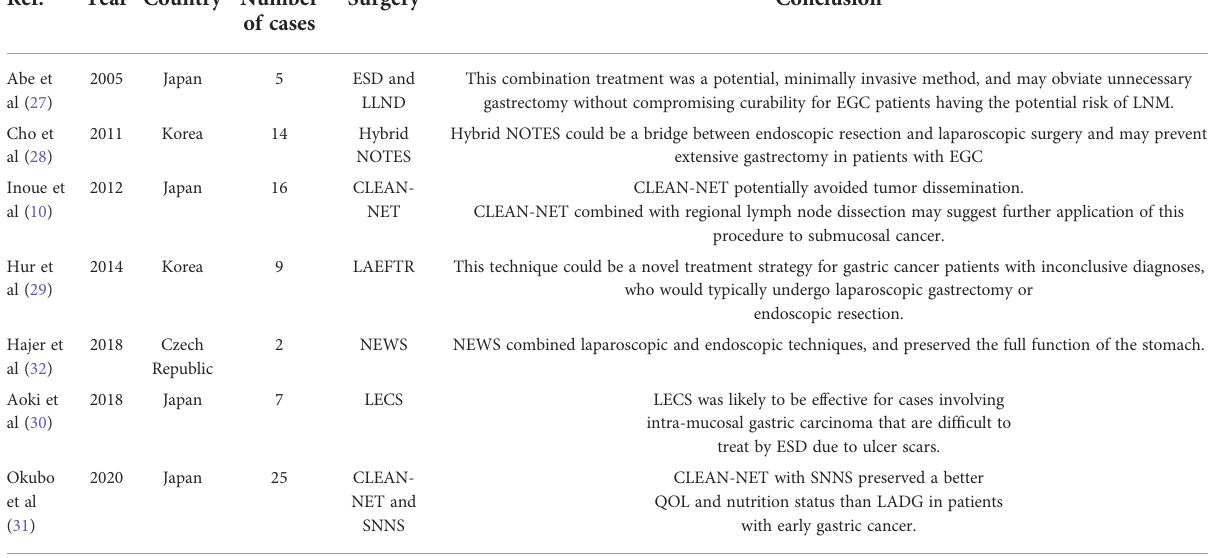
TABLE 1 Summary of studies related to LECS for EGC.